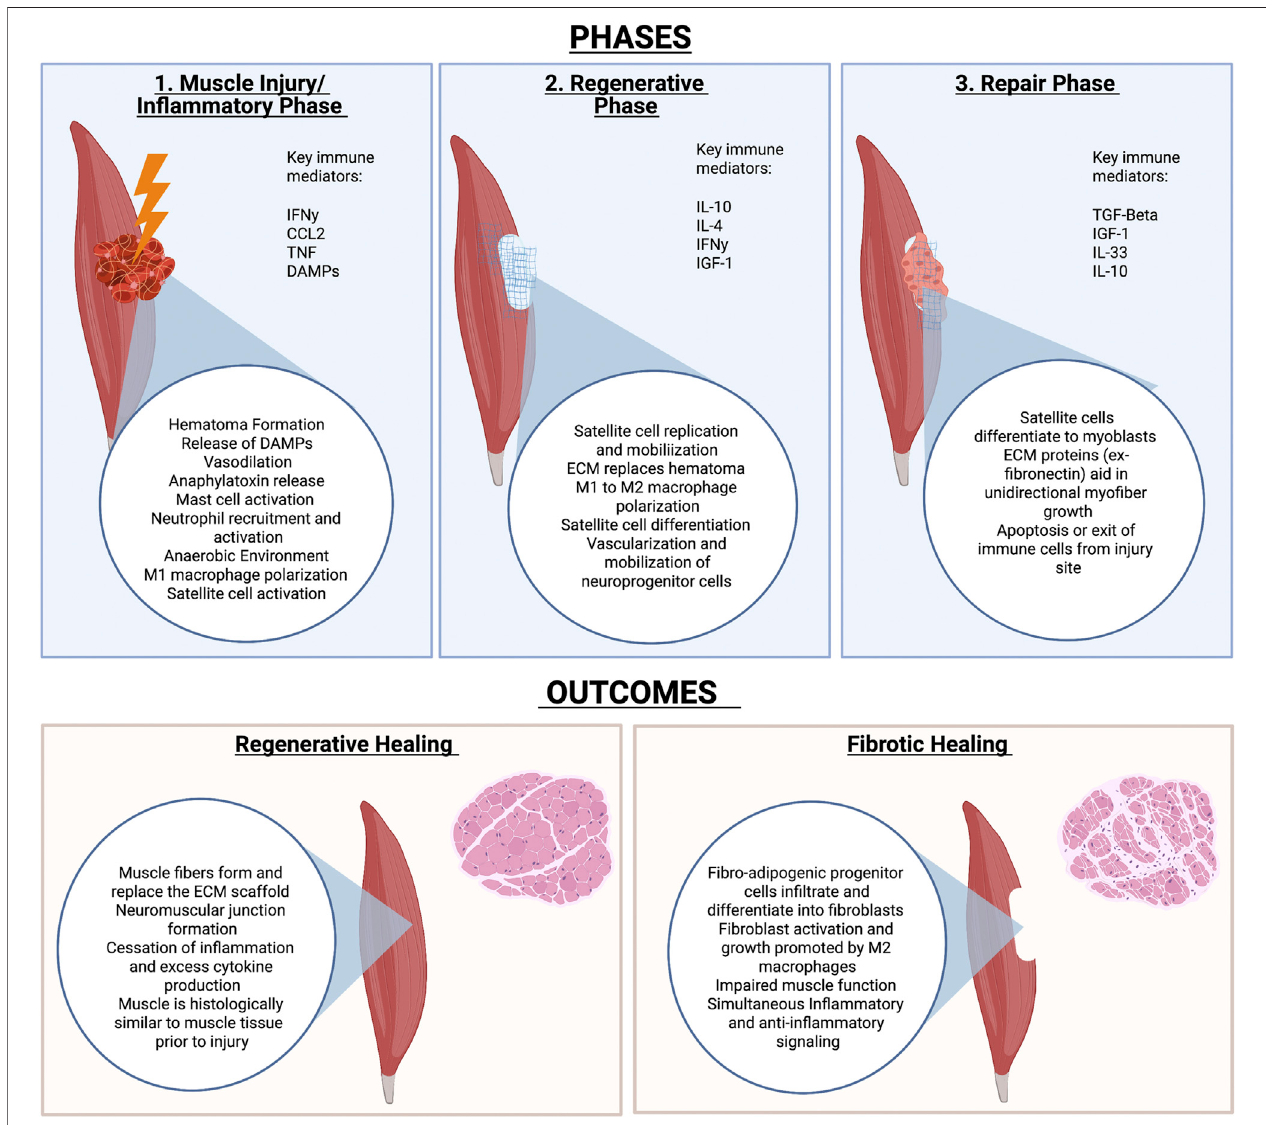
FIGURE 2 | Phases of muscle healing and potential outcomes. Muscle Injury is largely characterized by an in fl ammatory, regenerative and repair phase. The outcome of injury depends on many factors but includes either full regeneration of injured tissue or fi brosis of the tissue that results in impaired function.